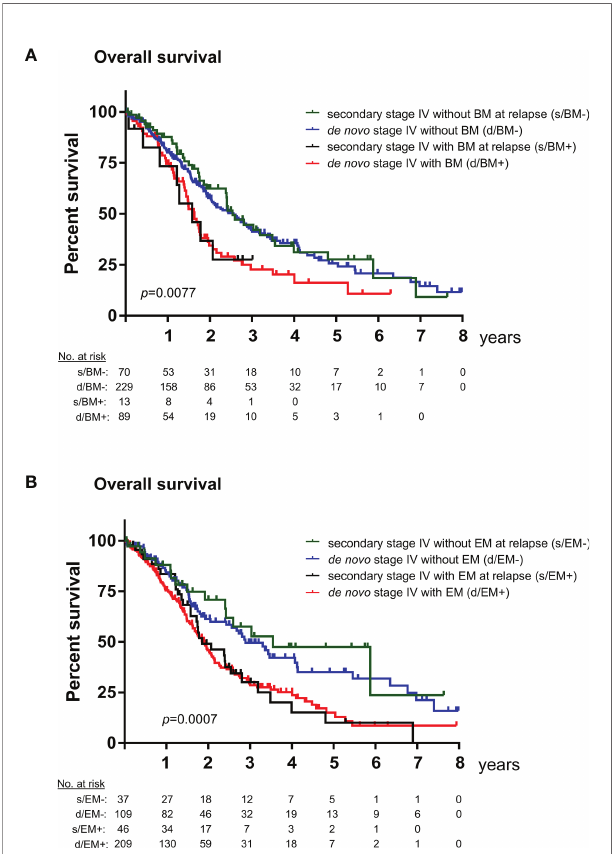
FIGURE 2 | Overall survival of TKI-treated EGFR + NSCLC patients with de novo vs. secondary metastatic disease by the presence of brain and extrathoracic metastases. (A) Median overall survival (OS) from the diagnosis of metastatic disease for TKI-treated EGFR + NSCLC was 30 months (standard error [SE] 2.5) for patients with secondary stage IV disease without brain metastases (BM, n = 70), 31 months (SE 3.3) for patients with de novo stage IV disease without BM (n = 229), 19 months (SE 5.0) for patients with secondary stage IV disease and BM (n = 13), and 20 months (SE 1.5) for patients with de novo stage IV disease and BM (n = 89, logrank p = 0.008). In a bivariable Cox regression, only presence of brain metastases at diagnosis of stage IV disease (hazard ratio [HR] = 1.65, p = 0.001), but not presence of de novo vs. secondary metastatic disease (HR 1.06, p = 0.75) was a signi fi cant predictor for OS in our entire cohort (n = 401). (B) Median OS from the diagnosis of metastatic disease for TKI- treated EGFR + NSCLC was 43 months (SE 12) for patients with secondary stage IV disease without extrathoracic metastases (EM, n = 37), 35 months (SE 4.4) for patients with de novo stage IV disease without EM (n = 109), 22 months (SE 4) for patients with secondary stage IV disease and EM (n = 46), and 23 months (SE 1.5) for patients with de novo stage IV disease with EM (n = 89, logrank p < 0.001). In a bivariable Cox regression, only presence of extrathoracic metastases at diagnosis of stage IV disease (HR = 1.79, p < 0.001), but not presence of de novo vs. secondary metastatic disease (HR = 1.09, p = 0.62) was a signi fi cant predictor for OS in our entire cohort (n =